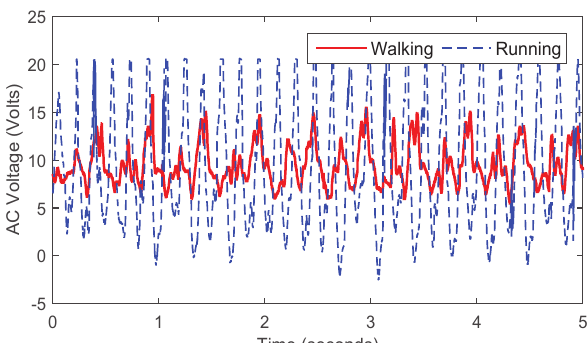
Walking Running